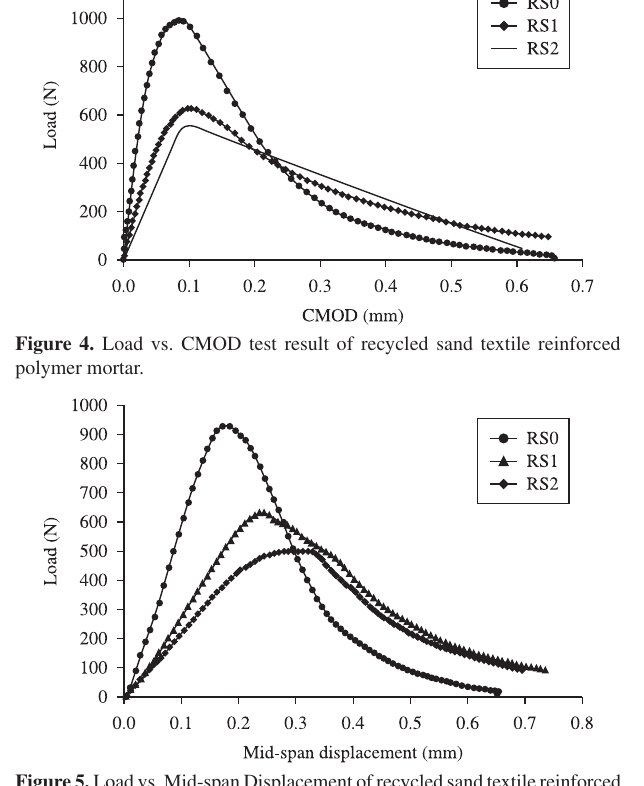
Figure 7. Polymer mortar fracture energy comparison.